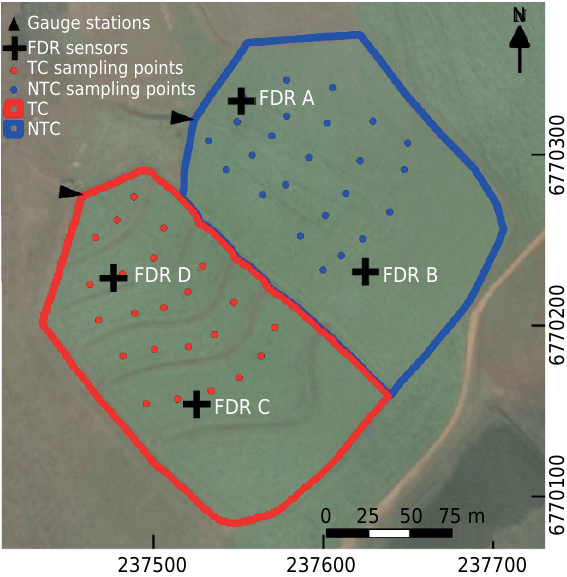
Figure 3. Sampling for crop grain yields and moisture monitoring points in the non-terraced catchment (NTC) and terraced catchment (TC) in Rio Grande do Sul State, southern